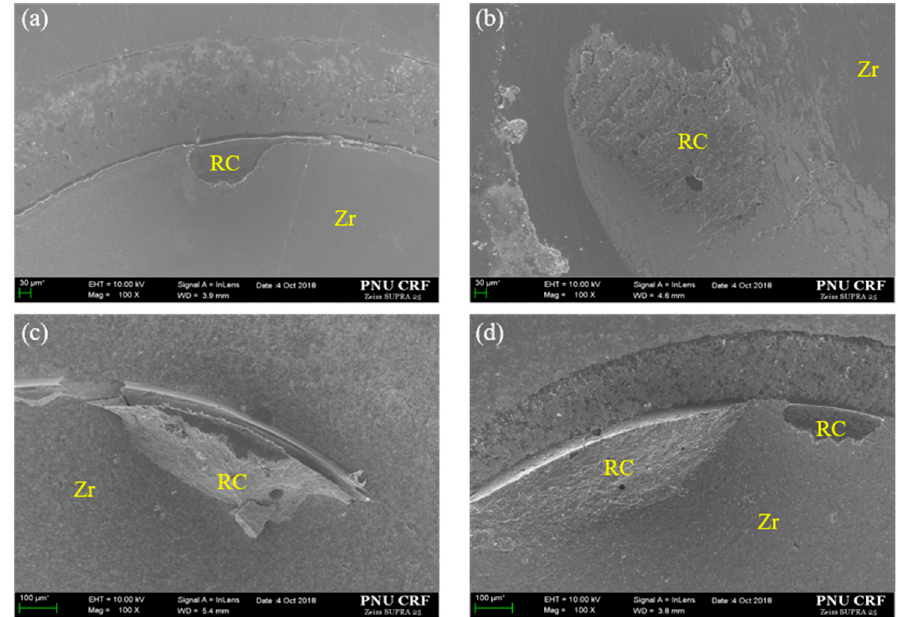
Figure 8. Representative FE-SEM images (×100) of the Y-TZP for each surface treatment method after thermal cycling and SBS test. ( a ) Pr, Zirconia primer; ( b ) NTP + Pr, NTP + Zirconia primer; ( c ) Sb + Pr, Sandblasting + Zirconia primer; ( d ) Sb + NTP + Pr, Sandblasting + NTP + Zirconia primer. ( a–d ) show mixed failures. RC, resin cement; Zr, Y-TZP surface.